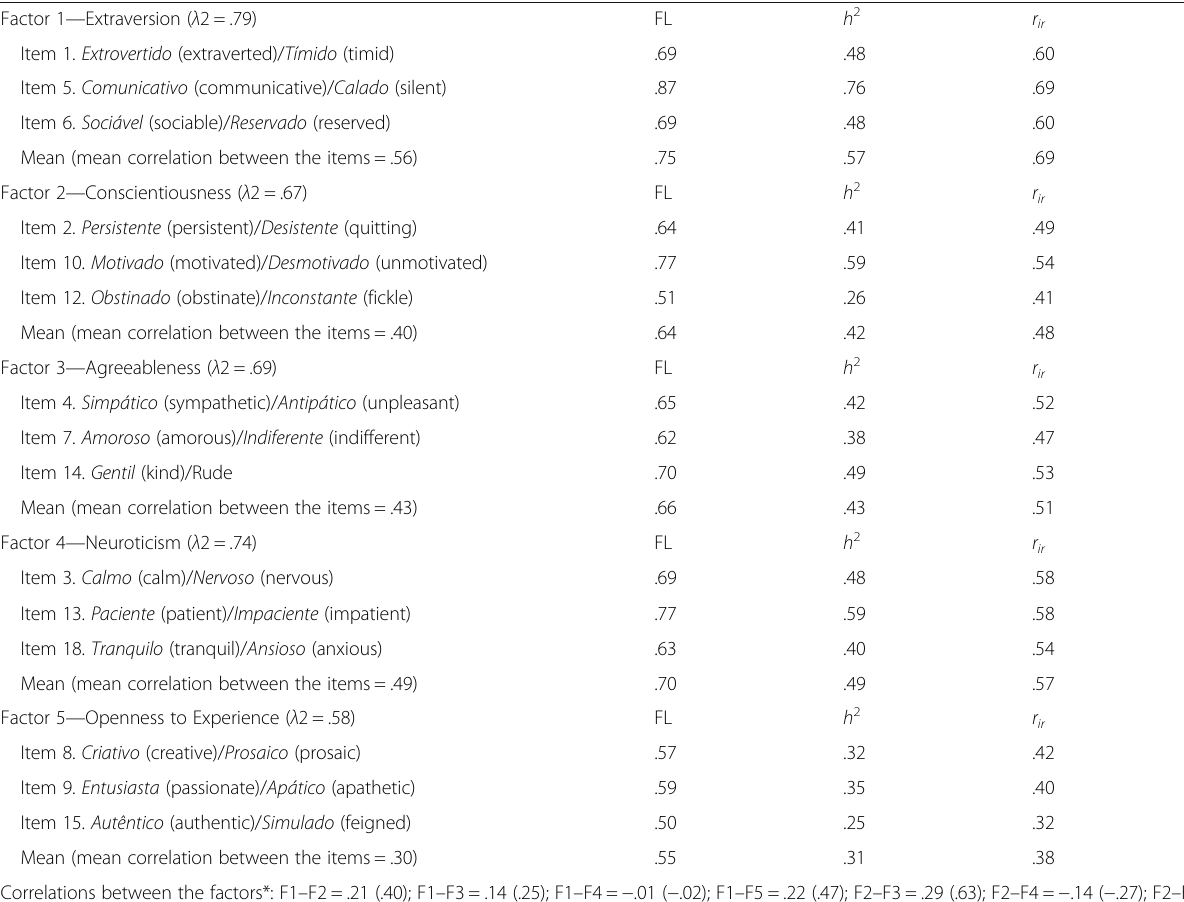
Table 3 ER5FP: reliability coefficients (Guttman ’ s λ 2), factor loadings (FL), communalities ( h 2 ), item-rest correlations ( r ir ), and correlations between factors ( N =